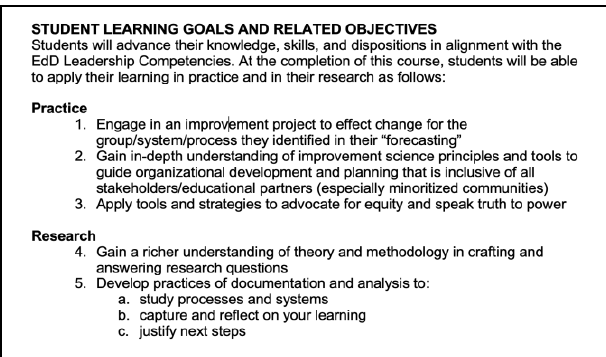
Figure 1. Course Learning Goals and Objectives